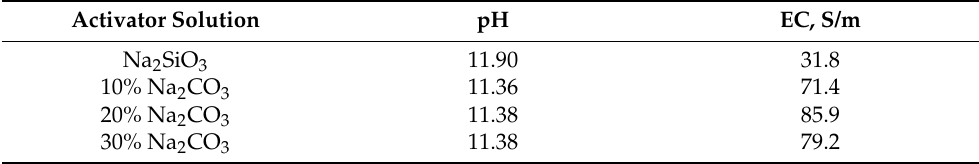
Table 3. EC and pH characteristics of Na 2 SiO 3 solution and different Na 2 CO 3 solutions.